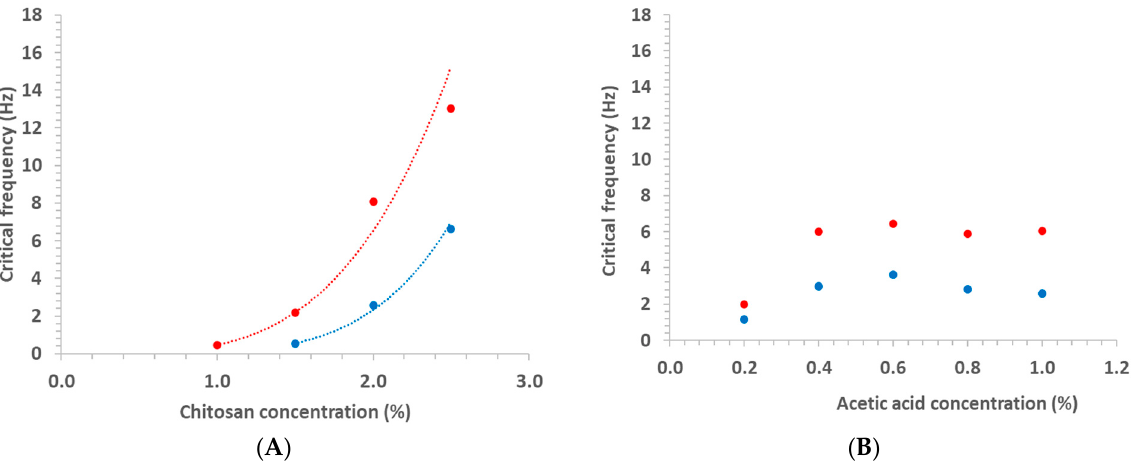
Figure 7. Variation of the critical frequency for G’ drop as a function of chitosan concentration ( A ) and acetic acid concentration ( B ), at 25 (red) and 45 °C (blue).